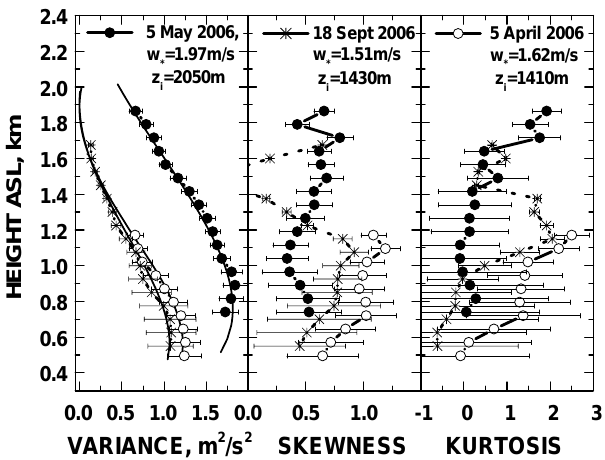
Fig. 3. Variance, skewness, and kurtosis of vertical velocity con- sidering measurements from 12:00–14:00LT on 5 April and 5 May 2006, and from 14:00–16:00LT on 18 September 2006. Error bars indicate sampling errors calculated after Lenschow et al. (1994). Instrumental noise is very low. Values for the convective scale w ∗ and mixing-layer top height z i for the analyzed two-hour periods are given as numbers. The respective variance profiles after Eq. (6) for these w ∗ and z i values are shown as solid lines in the variance plot (left).